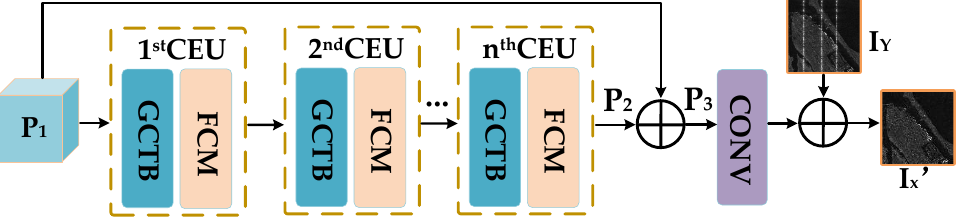
Figure 6. The overall structure of RRM. Where the black arrows indicate the transfer information stream and ⊕ denotes feature